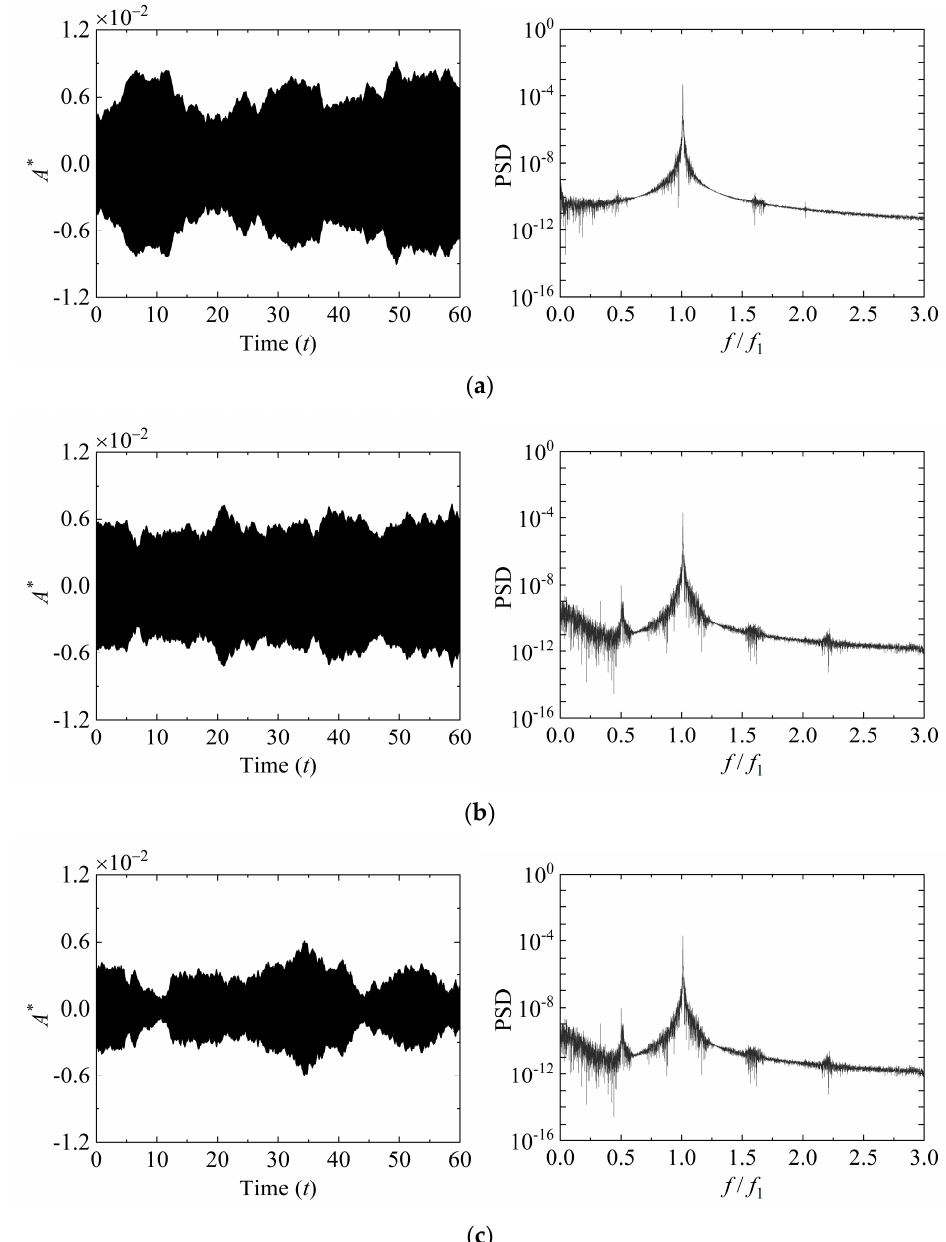
Figure 13. Comparison of the dimensionless displacement time histories and PSD for different tur- bulence intensity ( I u ) at the critical wind speed. ( a ) I u = 5.9% ( U* = 4.86); ( b ) I u = 9.7% ( U* = 4.73); ( c ) turbulence intensity ( I u ) at the critical wind speed. ( a ) I u = 5.9% ( U * = 4.86); ( b ) I u = 9.7% ( U * = 4.73); I u = 12.6% ( U* = 5.36). ( c ) I u = 12.6% ( U * =